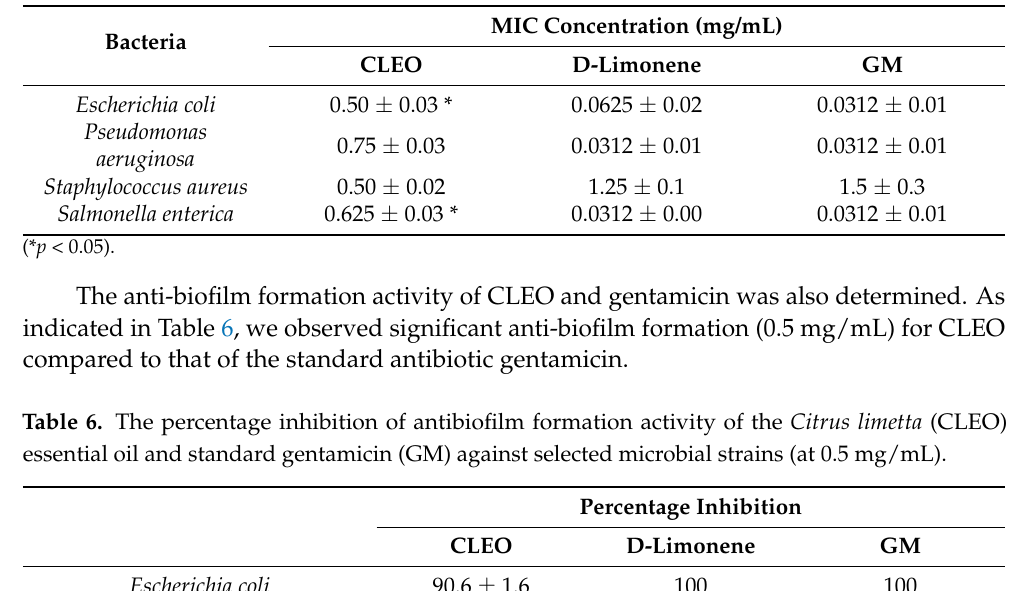
Table 5. Minimum inhibitory concentrations (mg/mL) of the Citrus limetta (CLEO) essential oil and standard gentamicin (GM) against selected microbial strains.